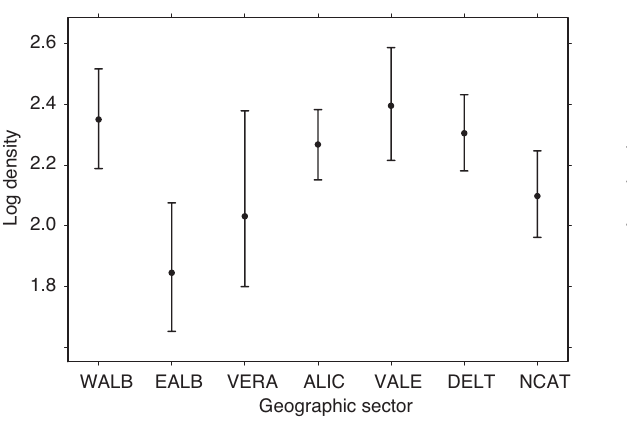
F IG . 9. – Annual variation of Liocarcinus depurator median densi- ty